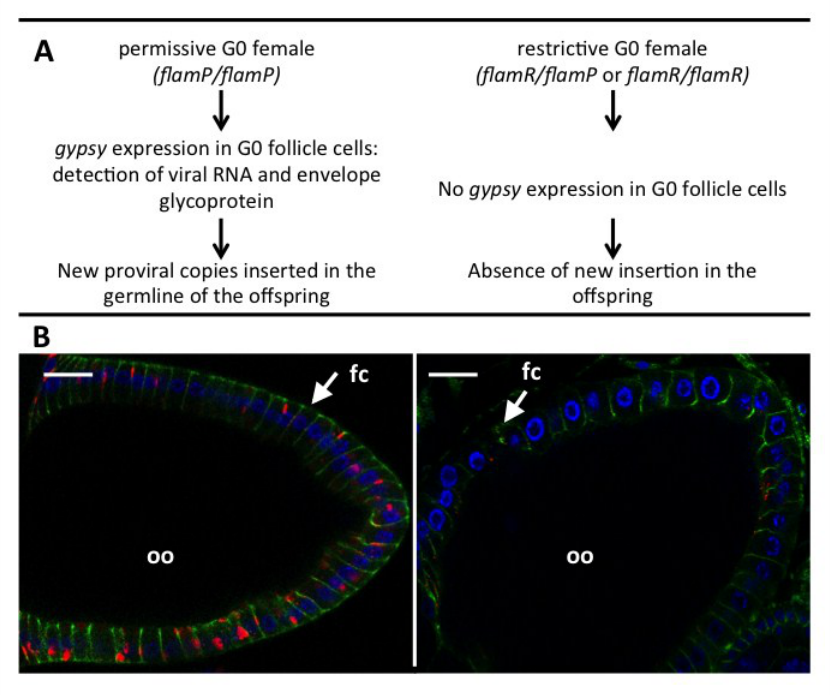
Figure 3. ( A ) Maternal control of gypsy replication by flamenco; ( B ) Immunostaining against gypsy envelope in permissive (left) and restrictive (right) egg chambers (scale bar 20 µm). Blue: Dapi; red: gypsy Env; green: Dlg, a cellular protein present at the junctions between follicle cells. fc: follicle cell; oo: oocyte.